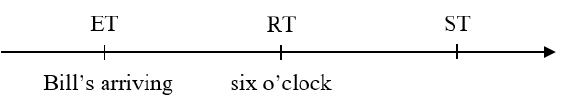
Figure 1. Perfect-in-the-past reading